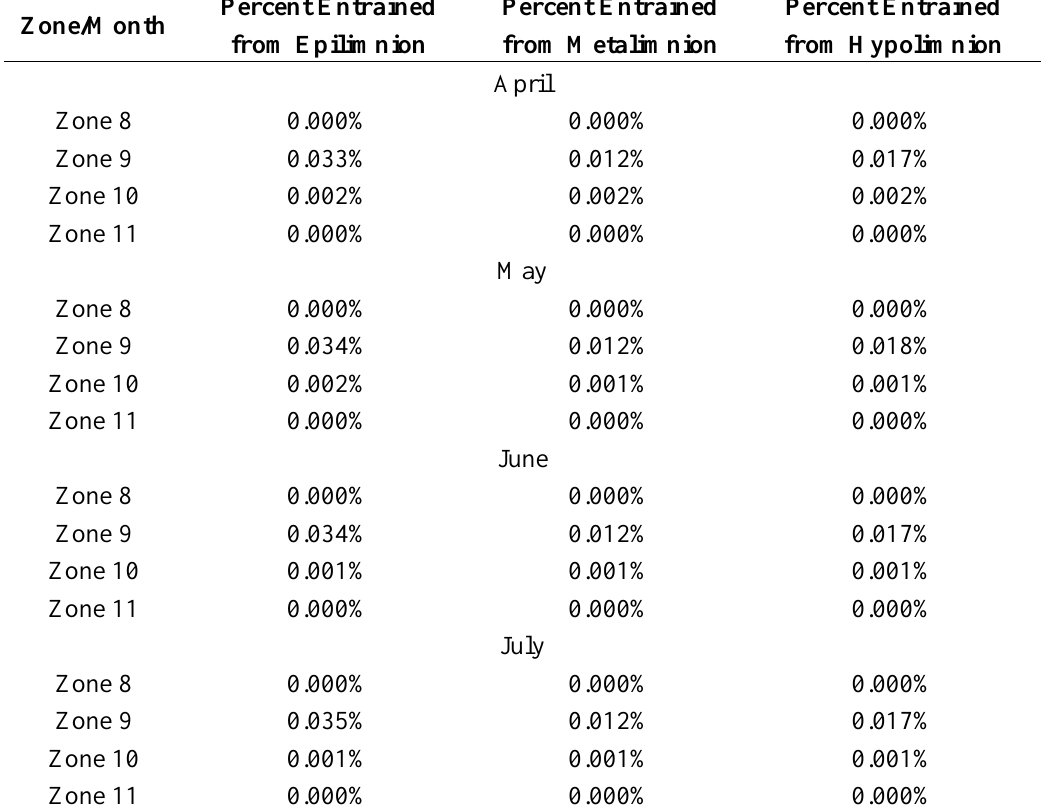
Table 2. Percent of each water layer entrained by ballasting—flood